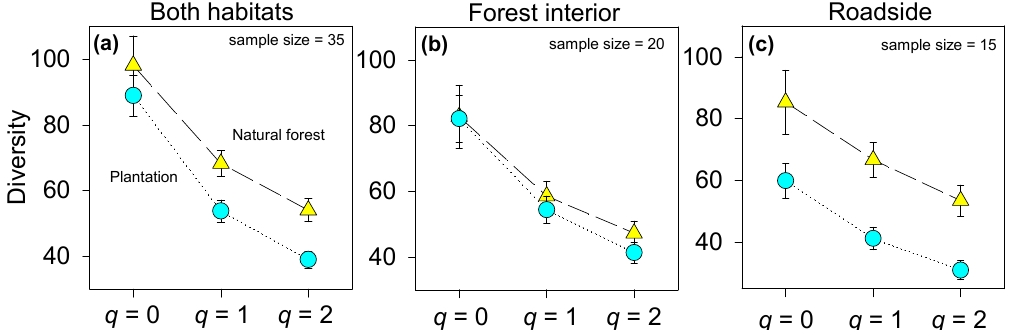
Figure 3. Regional native plant species diversity comparing plantations (cyan) and the natural forest (yellow). Diversity was quantified for Hill numbers q = 0, 1, and 2, which increasingly weight occurrence frequency of species, using sample-size based rarefaction and extrapolation to factor out differences in sample size. Sample size was chosen below the doubled minimum sample size of transects sampled within the natural forest. Diversity was estimated for ( a ) forest interiors and roadsides combined (both habitats) as well as for ( b ) forest interiors and ( c ) roadsides separately. * indicate significant differences between forest types.